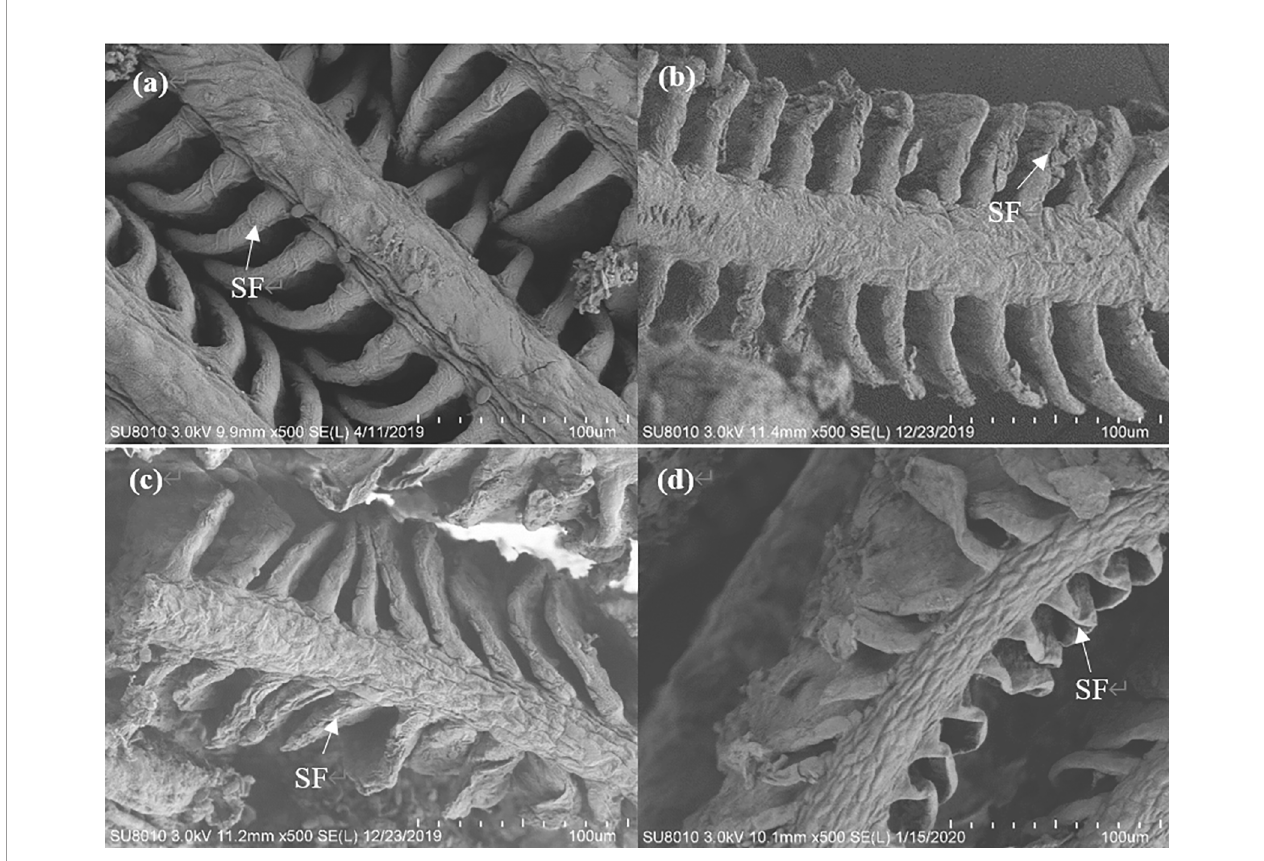
FIGURE 2 | Electron microscopy examinations of gill sections under (A) normoxia, (B) hypoxia, (C) semi-asphyxia, and (D) asphyxia stress in silver carp. SF: branch